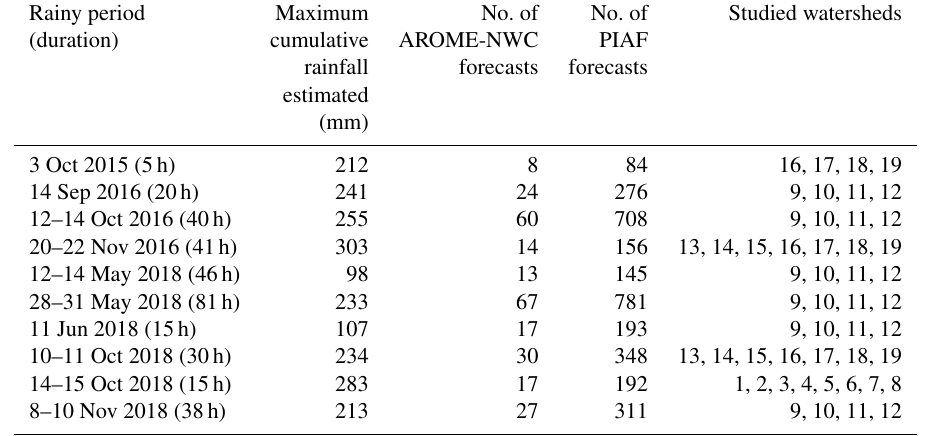
Table 2. Characteristics of the studied events and number of forecasts. Quantitative precipitation estimates come from ANTILOPE product. Rainy period Maximum No. of No. of Studied watersheds (duration) cumulative AROME-NWC PIAF rainfall forecasts forecasts estimated